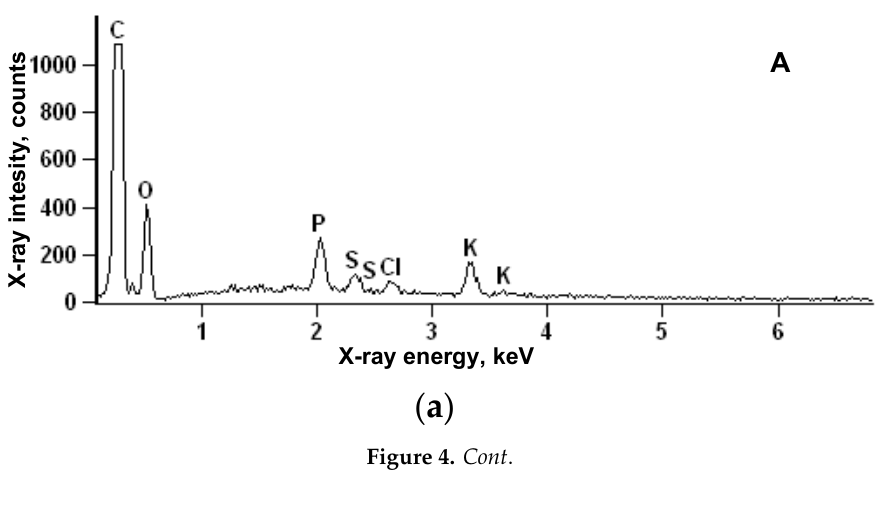
Figure 3. Sorption isotherms of Pt and Pd on ( a ) Saccharomyces sp. and ( b ) Aspergillus sp. Biosorption of Pt on yeast and fungi at pH 2, biosorption of Pd on yeast at pH 2.5, on fungi at pH 3.5, dry biomass 0.013 g, contact time 45 min.